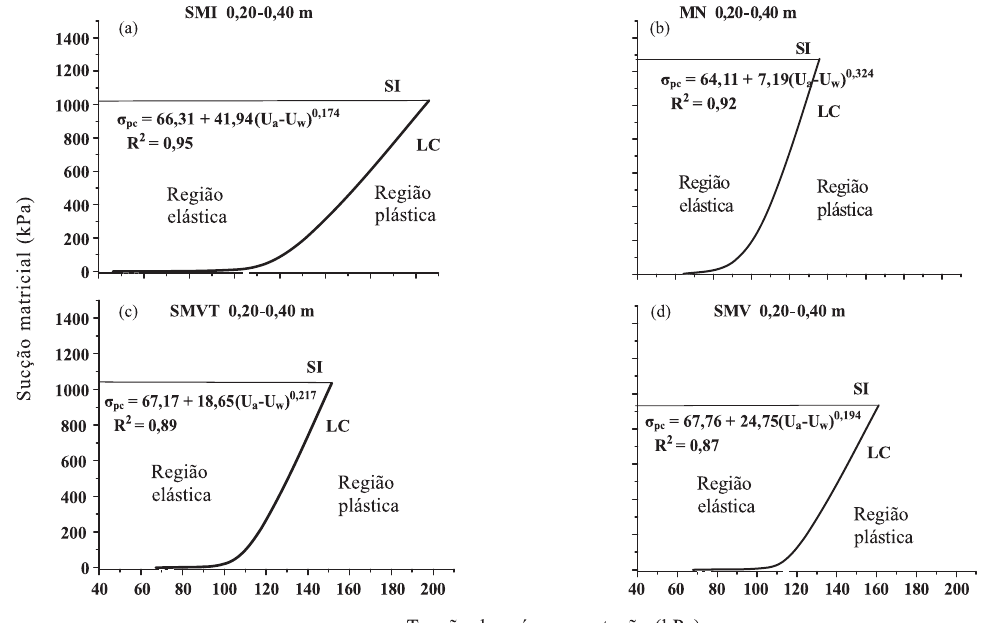
figura 3. sucção matricial em função da tensão de pré-compactação, para as quatro condições de sistemas de manejo, na profundidade de 0,20–0,40 m.